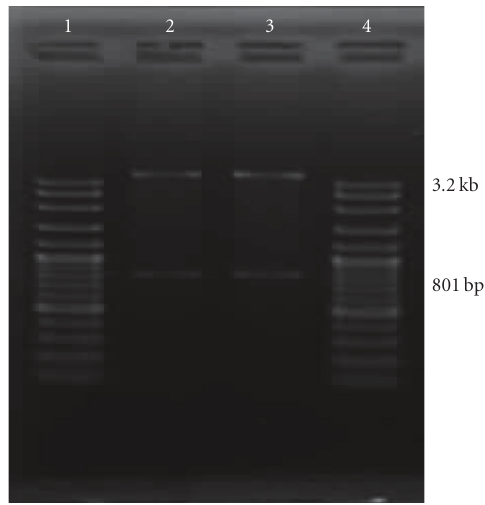
Figure 1: Agarose gel electrophoresis analysis of two-step RT-PCR amplified NS1 gene of AIV using NS1F and NS1R primers.